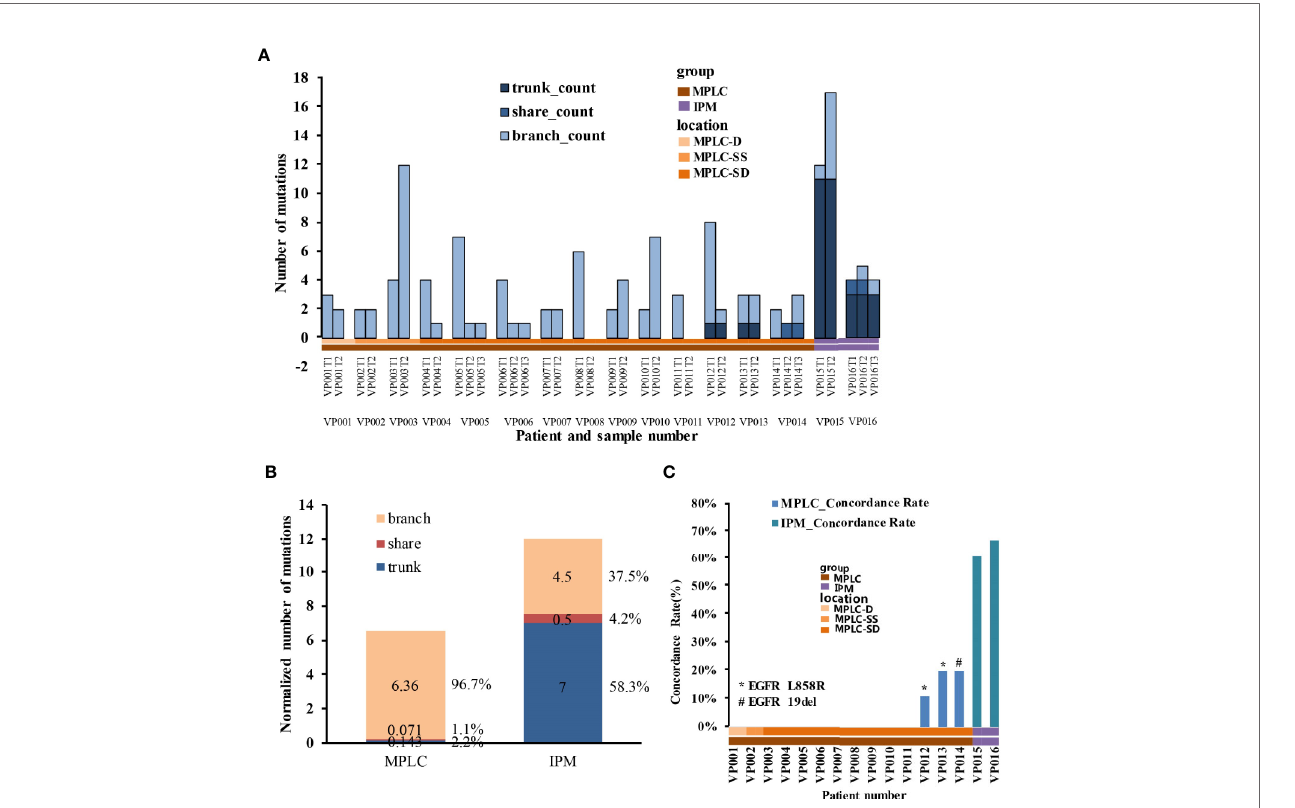
FIGURE 5 | Mutation status and concordance rate for lesions of the validation cohort. Panel (A) The number of mutations for all lesions of all patients with MPLC or IPM. Trunk, shared, and branch mutations are shown as indicated. Panel (B) Comparison of the normalized number of mutations (total number of mutations/number of patients) for MPLC and IPM. The ratio of trunk, shared, and branch mutations are shown as indicated. Panel (C) The concordance rate for each patient, with key common driver genes labeled. MPLC-SD, lesions at the same lung but different lobes; MPLC-SS, lesions at the same lung and same lobe; MPLC-D, lesions at bilateral